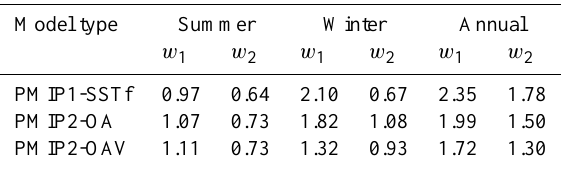
, w 2 = 1 n σ 2 i + 1